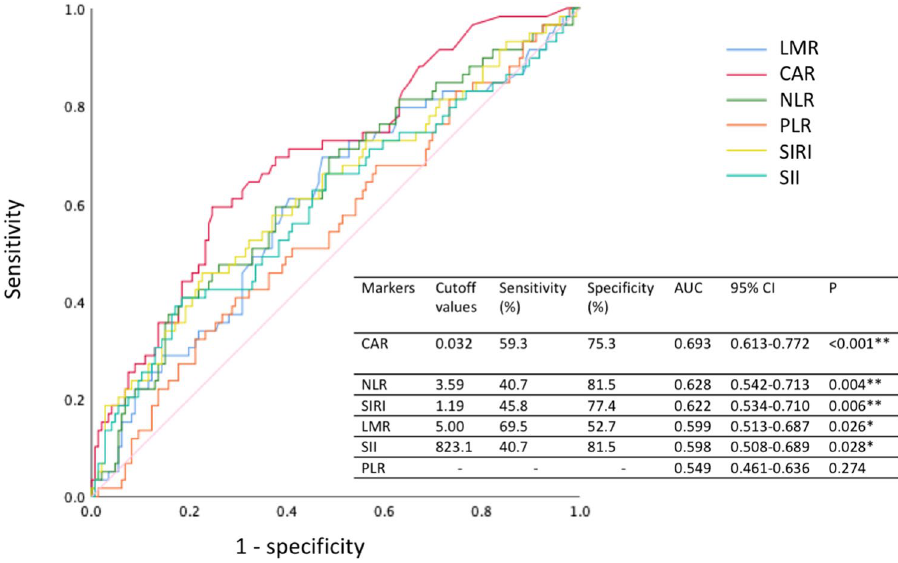
Figure 1. Receiver operating characteristic (ROC) curves of the inflammatory markers analyzed as predictors of the overall survival